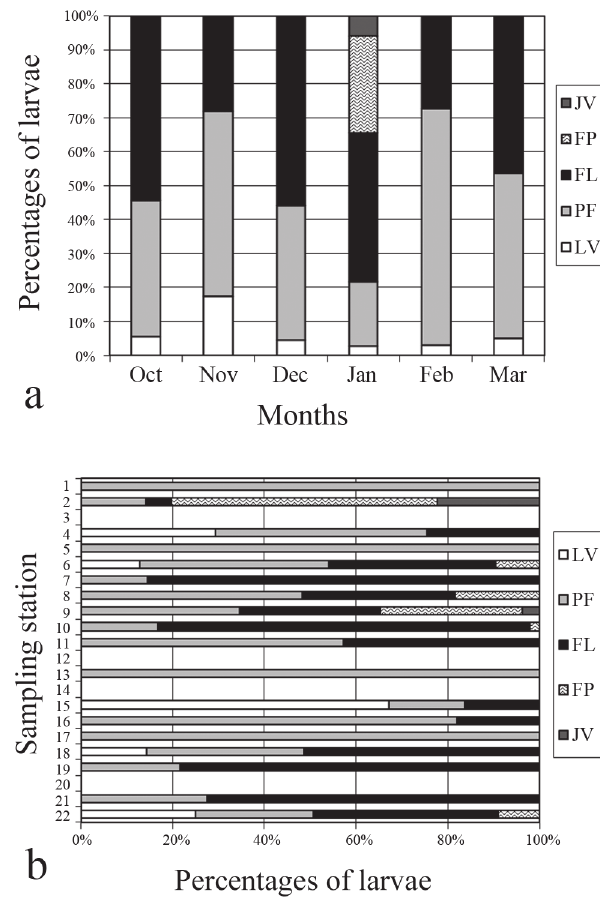
Fig. 3. Monthly density and per sampling stations of the larval development stages of Rhamdia quelen in Ilha Grande National